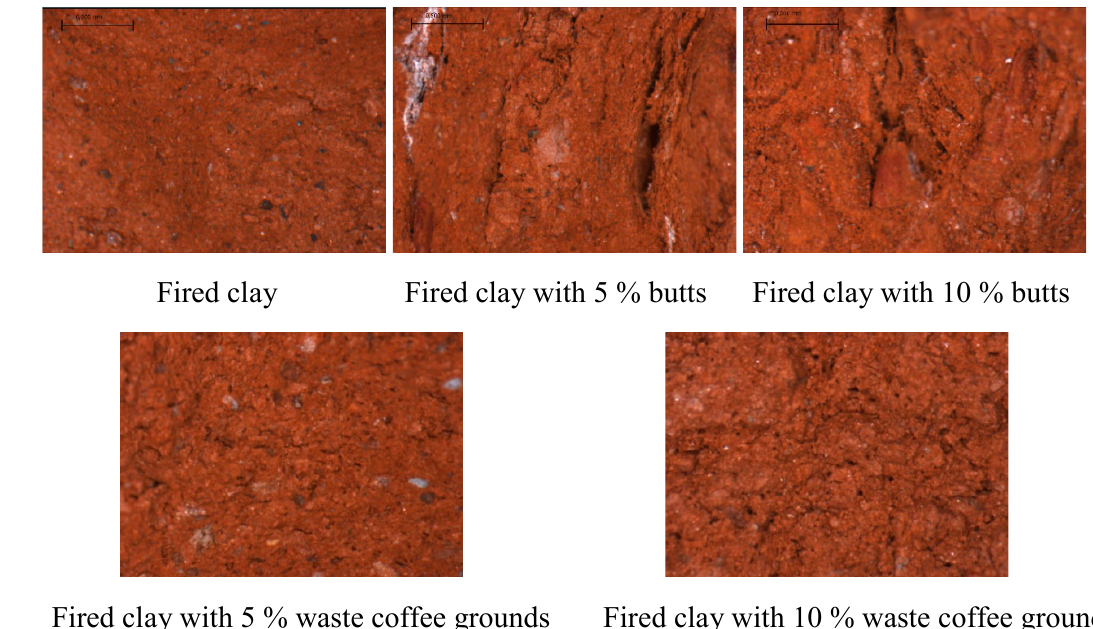
Figure 6. Optical microscopy images of fired clay and fired clay with